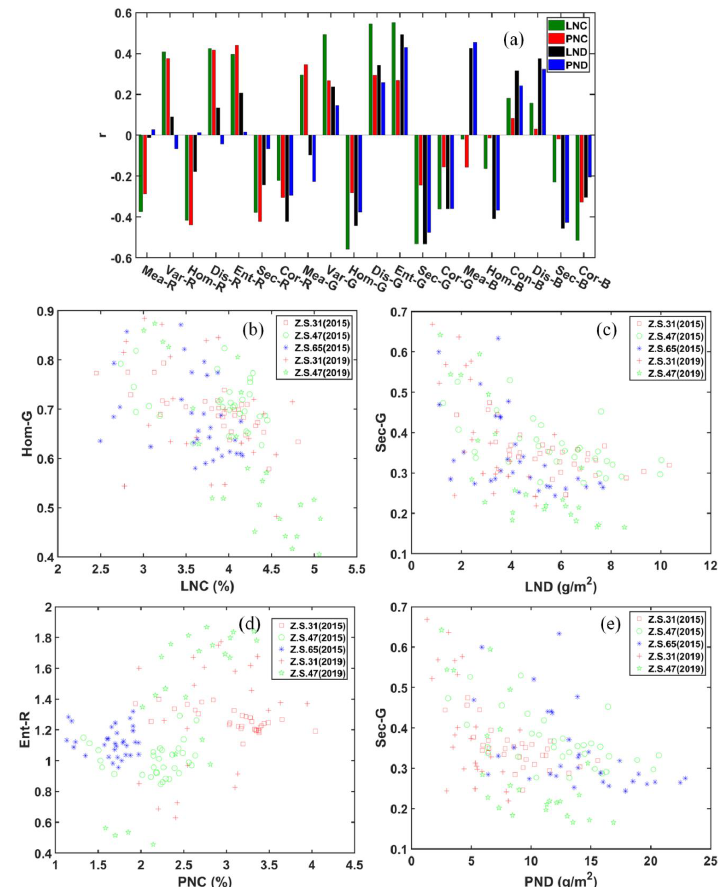
Figure 8. The responses of different GLCM-based textures to the four wheat N status indicators (i.e., LNC, PNC, LND, and PND) in the calibration dataset. ( a ) Pearson correlation analyses of GLCM- based textures and N status indicators, and ( b – e ) scatter plots of the best performing GLCM-based textures and N status indicators for each growth stage.